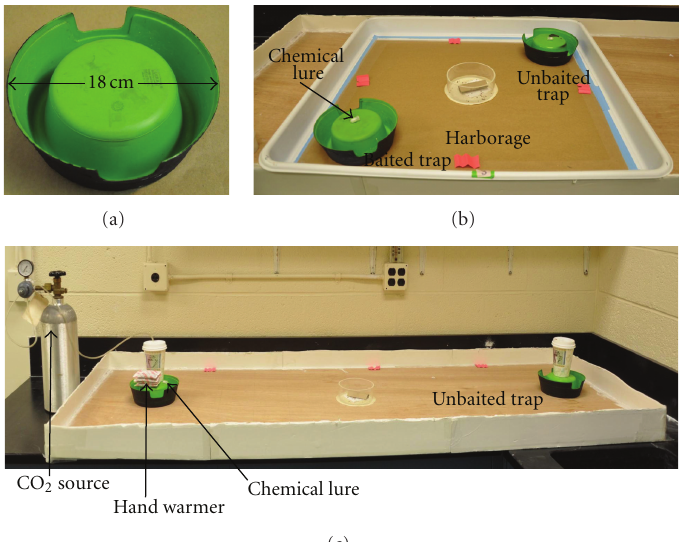
Figure 1: Experimental setup for determining bed bug attraction to nonchemical and chemical lures: (a) pitfall trap used in all bioassays; (b) a plastic tray arena with a baited and an unbaited trap; (c) a wooden door arena with a baited trap and an unbaited trap.